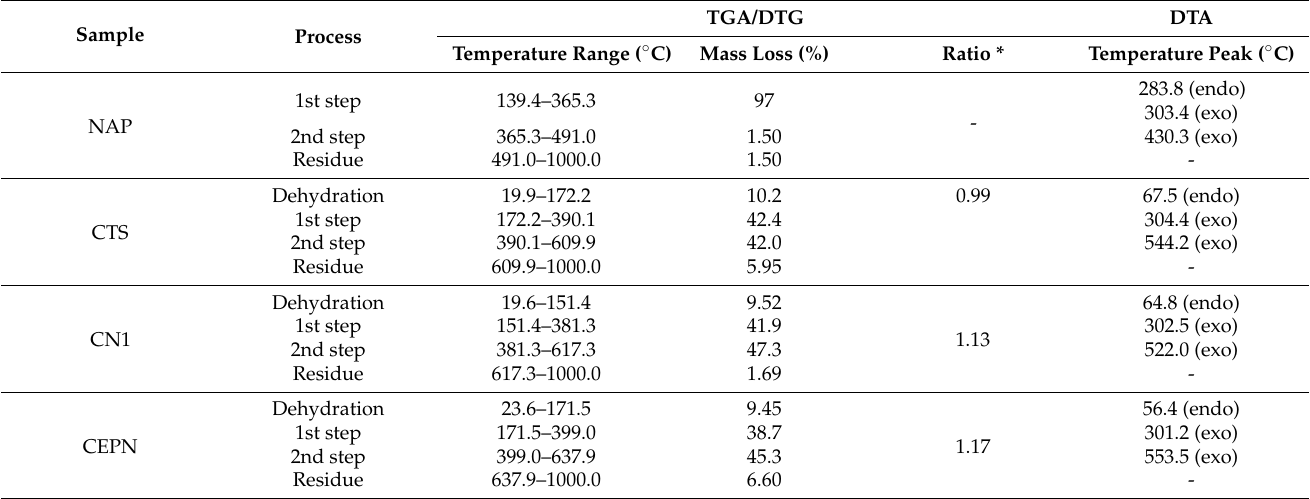
Figure 3. ( a ) TG/DTG and ( b ) DTA curves of NAP, CTS, CN1 and CEPN obtained in dynamic air atmosphere, flowing at 50 mL min − 1 , sample mass 7.0 ± 0.1 mg, in open α -alumina sample holders, with a heating rate of 10 ◦ C min − 1 . Table 5. Temperature ranges, percent mass loss, ratio between second and first mass losses and DTA peaks.